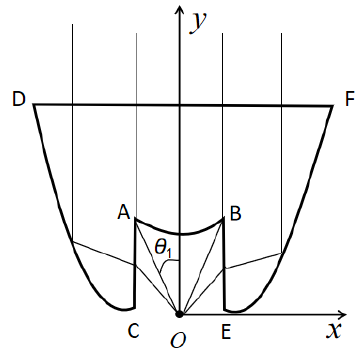
Figure 5. Optical design working principle diagram.